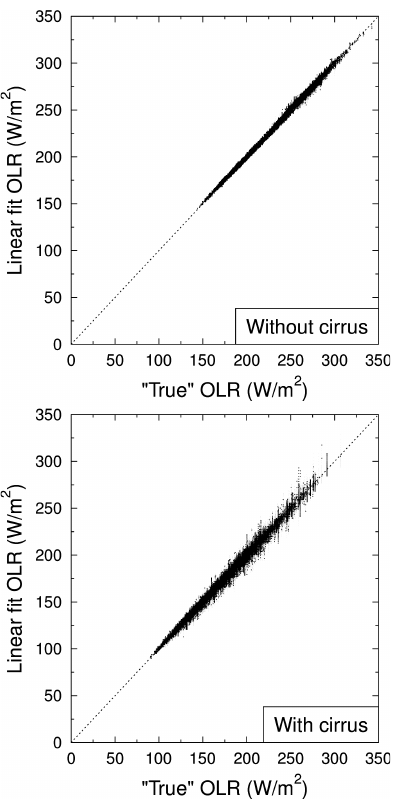
Fig. 2. Comparison between “true OLR” and the linear fit for cirrus- free cases (top) and cases with cirrus clouds (bottom).